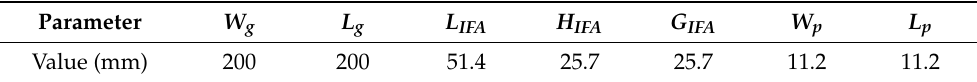
Figure 1. Illustration of the antenna system where ( a ) IFA is situated besides a patch antenna (affected) and ( b ) the patch antenna is mounted alone (unaffected). Table 1. Design parameters of the IFA and probe-fed patch